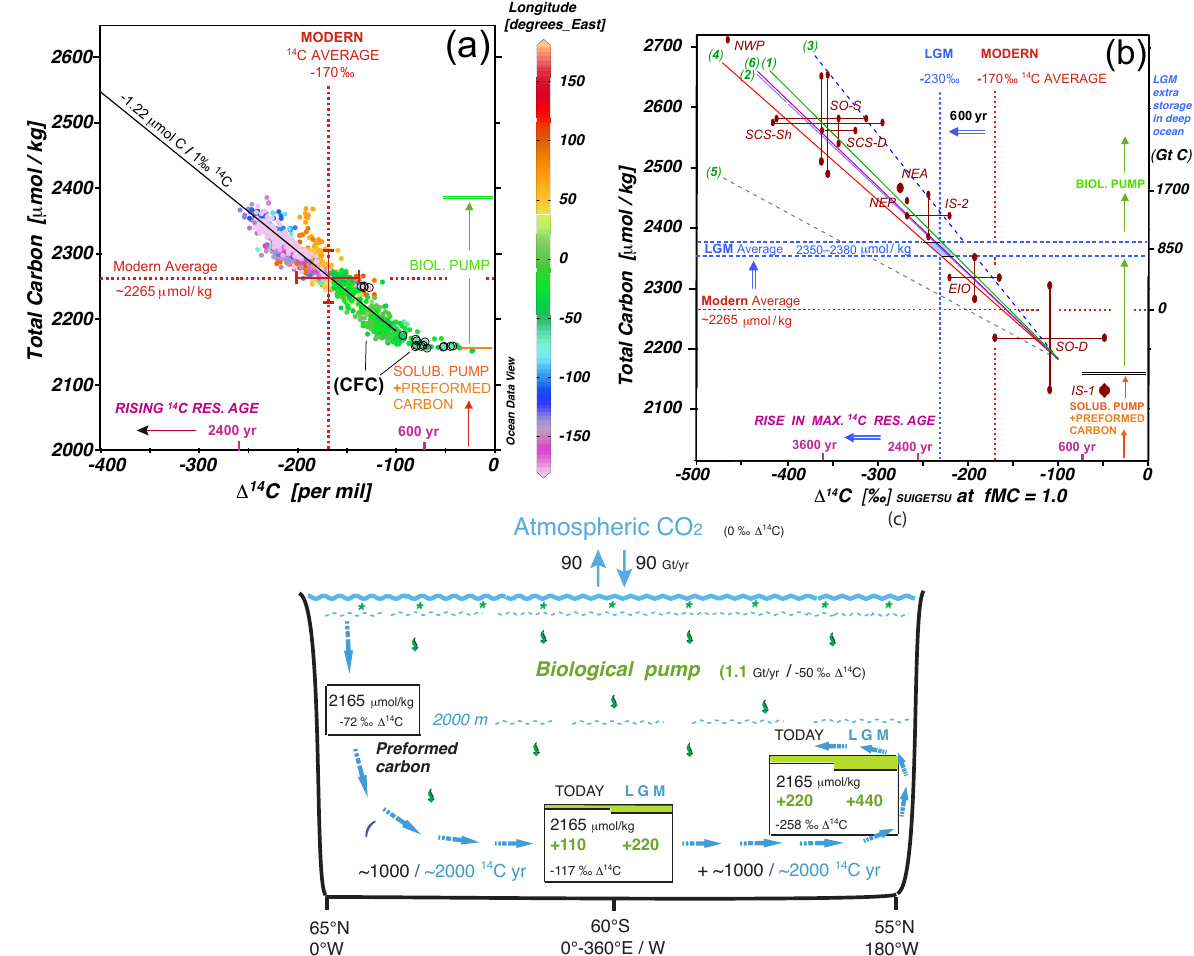
Fig. 2. (a) Ratio of total dissolved inorganic carbon (DIC) per kg vs. benthic 1 14 C and 14 C ventilation age forfMC = 1 of ocean waters paleo below >2000mw.d. (a) Modern, volumetrically unweighted GLODAP data (Key et al., 2004) for longitudes of the Atlantic (green), the western (orange) and eastern Indian Ocean and Pacific (pink and blue). Standard deviation is ± 32.8‰ for 1 14 C and ± 40.2µmolkg − 1 for DIC. Black open circles mark deep waters with chlorofluorocarbon (CFC) concentrations >0.1pmolkg − 1 as tracers of modern an- thropogenic influence in the northern North Atlantic and Weddell Sea Bottom Water (orange dots). Modern ventilation ages of 600 to 2400 14 Cyr average at 1500 14 Cyr = − 170‰ 1 14 C. (b) LGM regional estimates and LGM variability ranges of DIC– 1 14 C and age ratio (red oval dots) constrained for several key ocean regions: EIO = Eastern Indian Ocean; IS-1 = Icelandic Sea Mode 1; IS-2 = Ice- landic Sea Mode 2; NEA = Northeast Atlantic; NEP = Northeast Pacific; NWP = Northwest Pacific; SCS-S = shallow South China Sea; SCS-D = deep South China Sea; SO-D = deep Southern Ocean; SO-S = shallow Southern Ocean. Estimates were calculated using the assumption of stable regional regression slopes. Green numbers at upper left refer to sea regions defined in Fig. 3. Regression slopes are − 1.49µmolkg − 1 / 1 14 C (1), − 1.43µmolkg − 1 / 1 14 C (2), − 1.87µmolkg − 1 / 1 14 C (3), − 1.27µmolkg − 1 / 1 14 C (4), − 0.79µmolkg − 1 / 1 14 C (5), and − 1.44µmolkg − 1 / 1 14 C (6). Following (a) , 1 14 C values for intra-LGM age differences between atmosphere and deep-water ( = apparent benthic ventilation ages) and related DIC values are calculated for “paleo”fMC = 1 (Table 1). LGM ventilation ages show aver- age end members of <500 1 14 Cyr in the Icelandic Sea, ∼ 3600 14 Cyr in the Southern Ocean, and 5000 14 Cyr in the Northwest Pacific, and result in an overall conservative arithmetic mean of 2100 14 Cyr equal to − 230‰ of fMC (fraction of Modern Carbon). Blue values (µmolkg − 1 ) show mean DIC content of the deep ocean, estimated for a mean LGM ventilation age of 2100 14 Cyr.GtC scale at upper right labels total DIC mass in the LGM ocean, stored in addition to the modern 38100Gt DIC, with 1µmolDICkg − 1 corresponding to 8.5GtC in the total ocean at >2000mw.d. (deep-sea morphology of Amante and Eakins, 2009). Biol. Pump = “Biological Pump”, Solub. Pump = “Solubility Pump”. Blue arrows display Holocene-to-LGM shifts. (c) Scheme of the carbon inventory of ocean deep water for modern and LGM times. The 14 C ages and carbon contents are subject to a delicate balance between (1) the gradual aging of preformed carbon from the northern North Atlantic (black DIC values) up to the subpolar North Pacific and (2) the incremental absorption of young biogenic organic and inorganic carbon (green DIC values) supplied by the biological pump from the sea surface. During the LGM the average transit time (blue age values) was prolonged, hence the global effect of the biological pump possibly